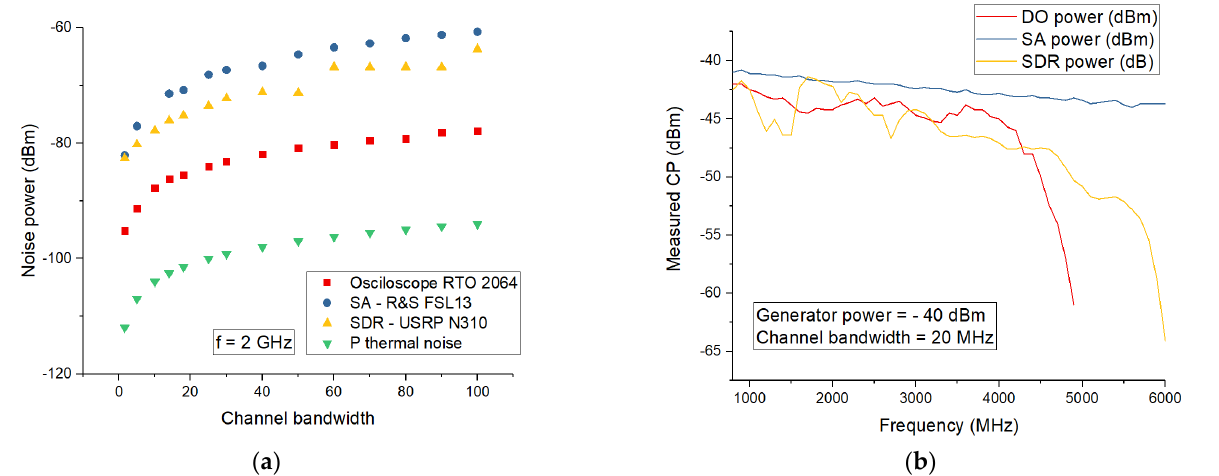
Figure 11. ( a ) Channel power of noise floor level at different channel bandwidths with different instru- ments. ( b ) Channel power of LTE signal—variation with frequency as measured by the three instru- ments.